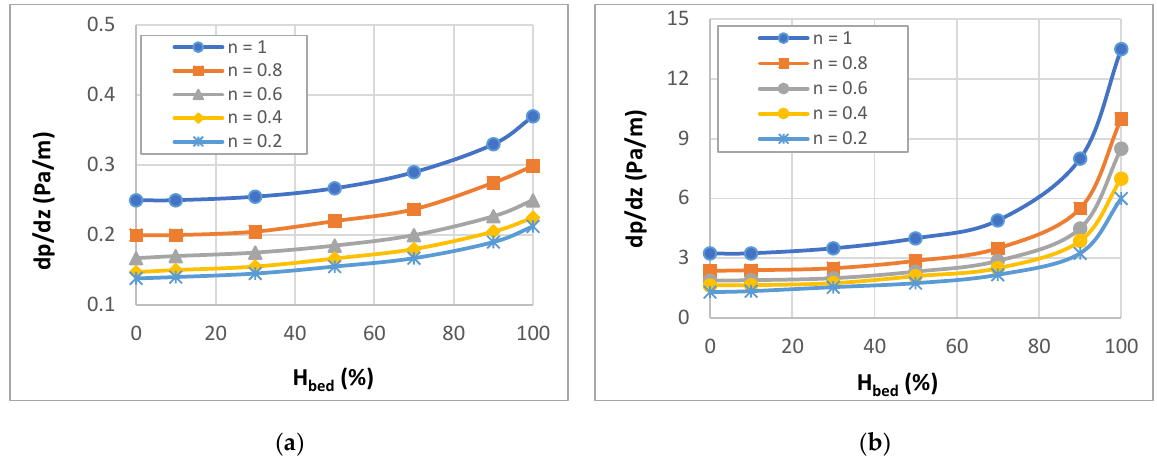
Figure 5. Pressure loss vs. bed height for conditions e = 0.9 and Q = 5 × 10 − 5 m 3 /s and different diameter ratios: ( a ) k = 0.25; and ( b ) k = 0.75.